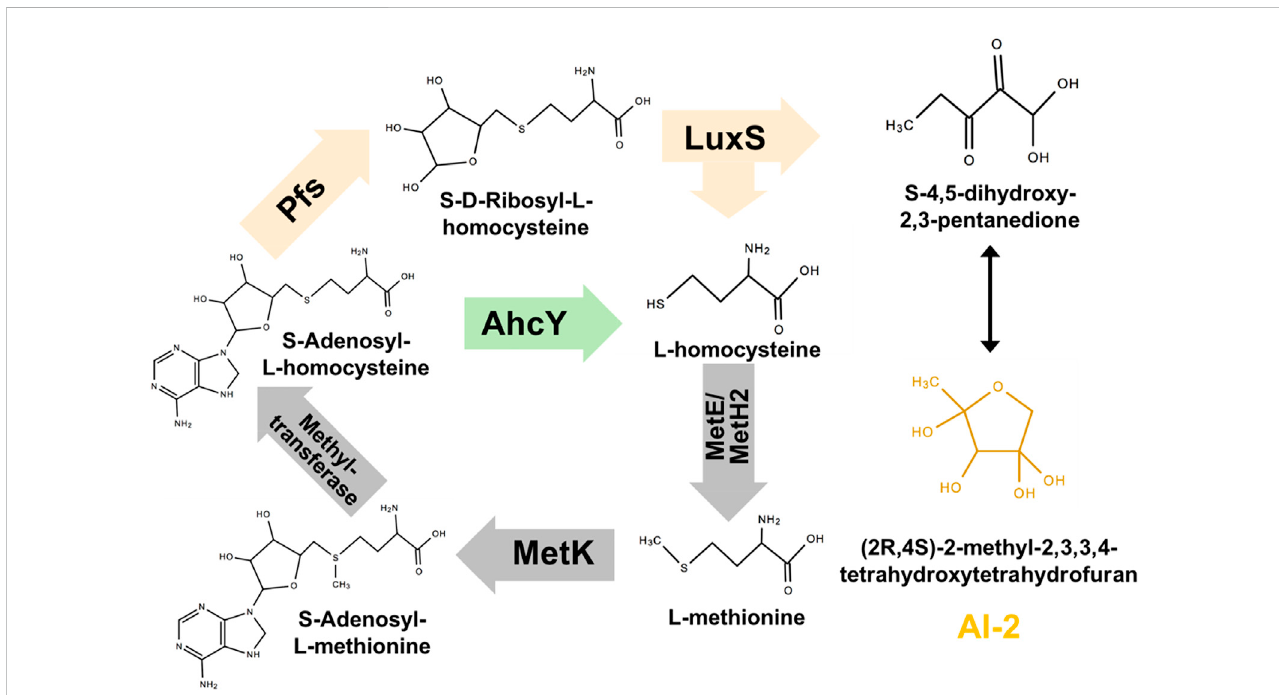
FIGURE 1 ConstructingexogenouspathwayforAI-2synthesisin Z.mobilis ZM4.TheorangegeneswereheterologouslyexpressedinZM4.Thegreengeneshould be